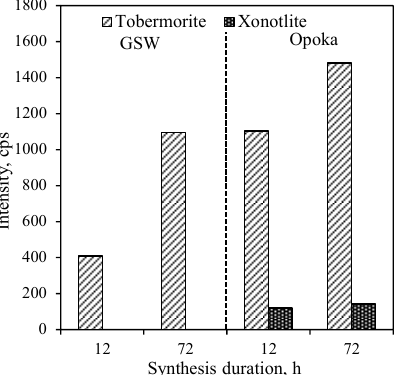
Figure 2. Intensity of the tobermorite ( d = 1.13 nm) and xonotlite ( d = 0.702 nm) peaks obtained from lime–GSW and lime–calcined opoka mixtures.